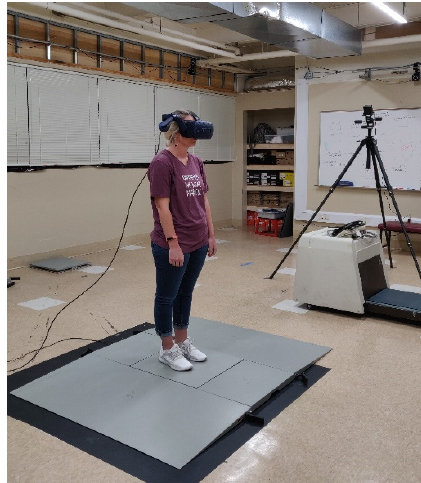
Figure 3. Participant being tested for postural stability wearing a virtual reality (VR) headset.